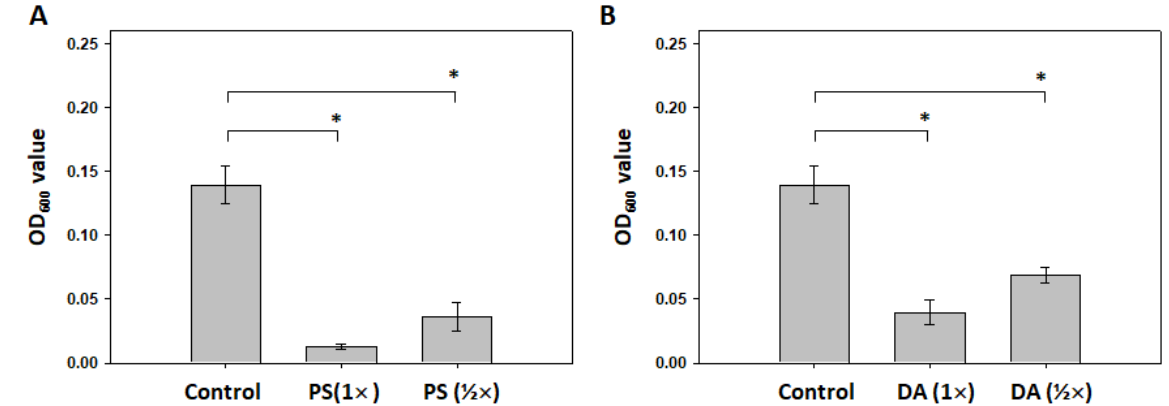
Figure 6. Inhibitory effect of fungicides against the growth of Bacillus amyloliquefaciens PMB04. To perform the assay, the overnight culture of PMB04 was transferred into 5 mL of fresh NB broth containing a full (1 × ) or half dose (1/2 × ) of pyraclostrobin (PS) or difenoconazole (DA). The OD values of bacterial culture at 600 nm were measured at 24 h post-treatment to check the growth of B. amyloliquefaciens PMB04. ( A , B ) show the OD values under treatment with PS and DA, respectively. Sterilized water was used as a negative control. Data represent mean ± SD, and the asterisks indicate significant differences compared with the control treatment assessed using a t -test ( p <